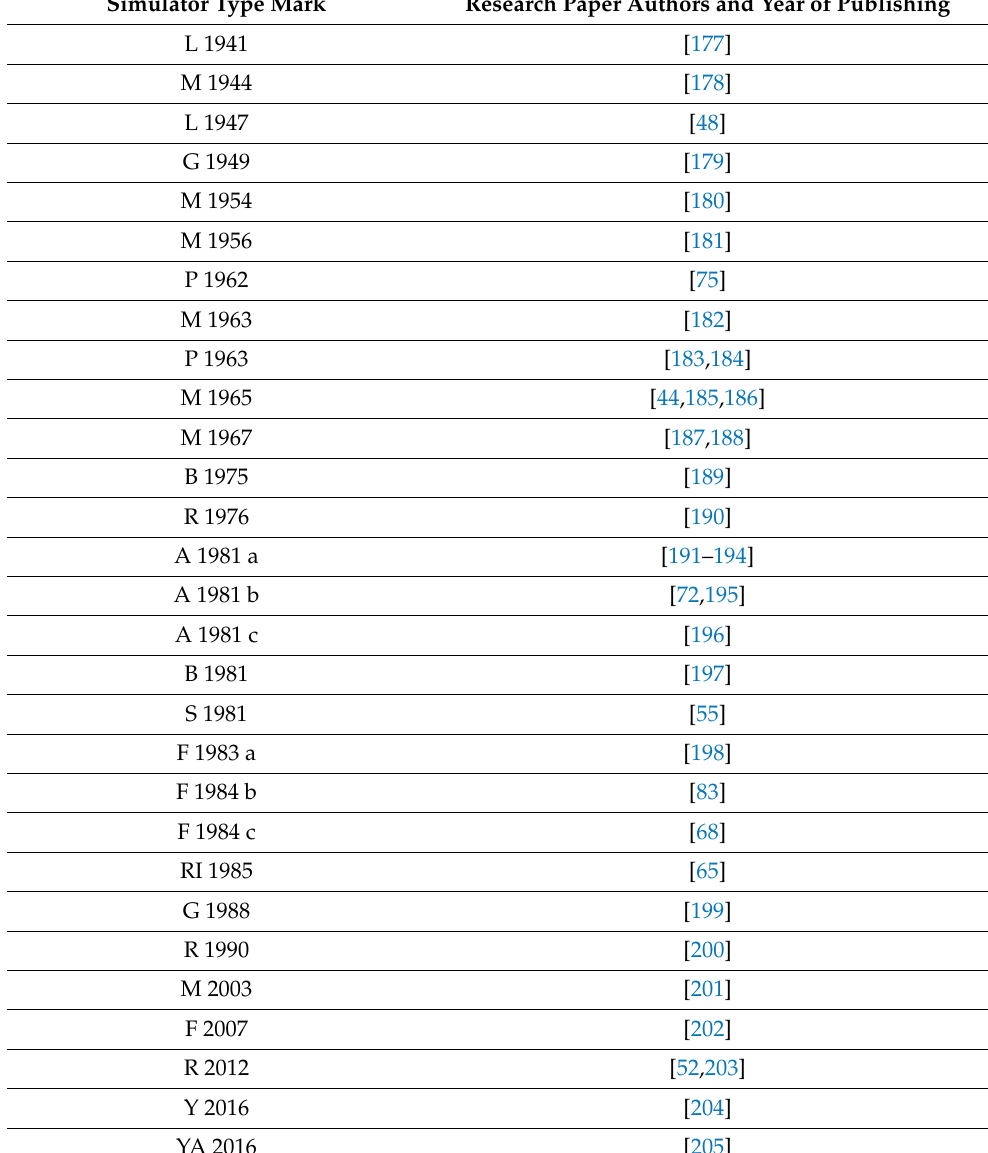
Table 2. DRS =1 with the listed sources of papers in which they are described or